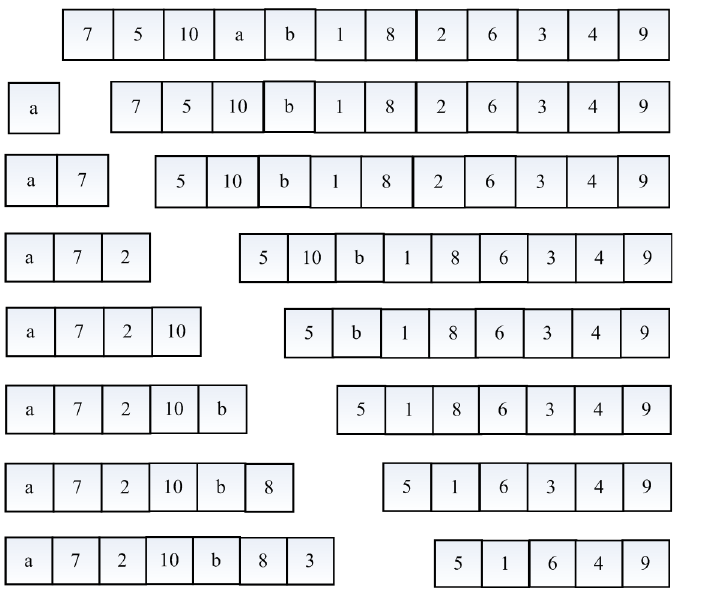
Fig 3. Coding and decoding schematic of chromosome segment